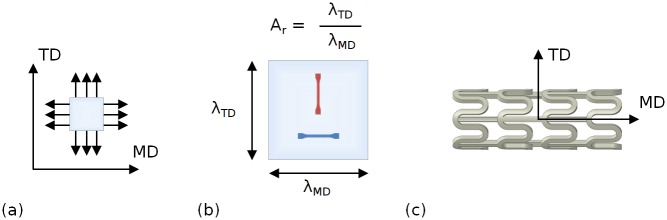
Schematic diagram showing (a) the biaxial stretching process in the machine direction (MD) and transverse direction (TD); (b) the definition of aspect ratio (Ar), defined as the quotient of the stretch ratio in the TD (λTD) and and the stretch ratio in the MD (λMD) and; (c) the alignment of the MD and the TD with a stent’s axial and circumferential axes, respectively.